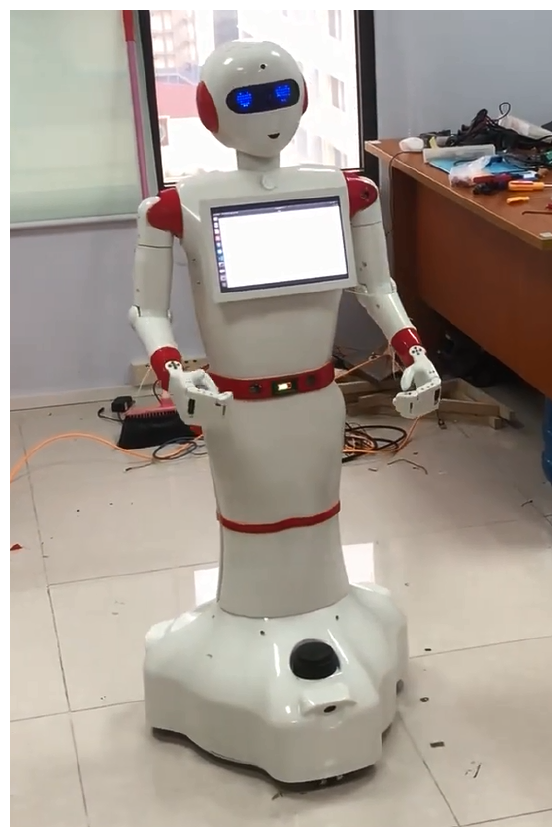
Figure 4. The self-developed intelligent humanoid robot BonBon that was used for testing the proposed